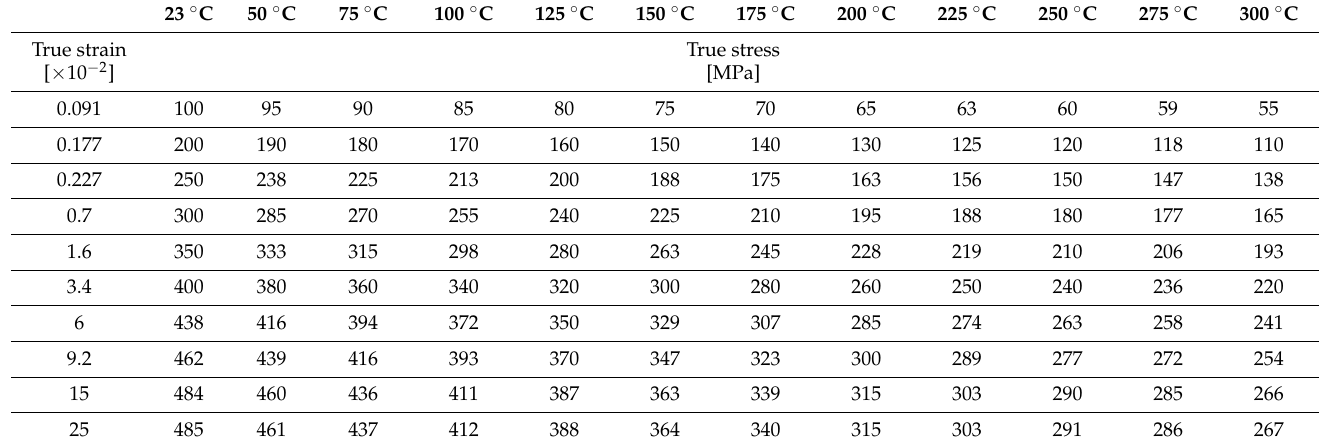
Table 3. Characteristic points of true stress vs. true strain